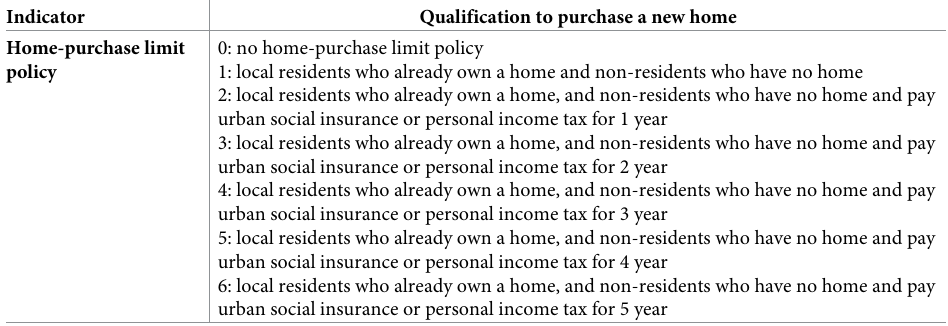
Table 1. Specific description of the indicators of home-purchase limit policy.